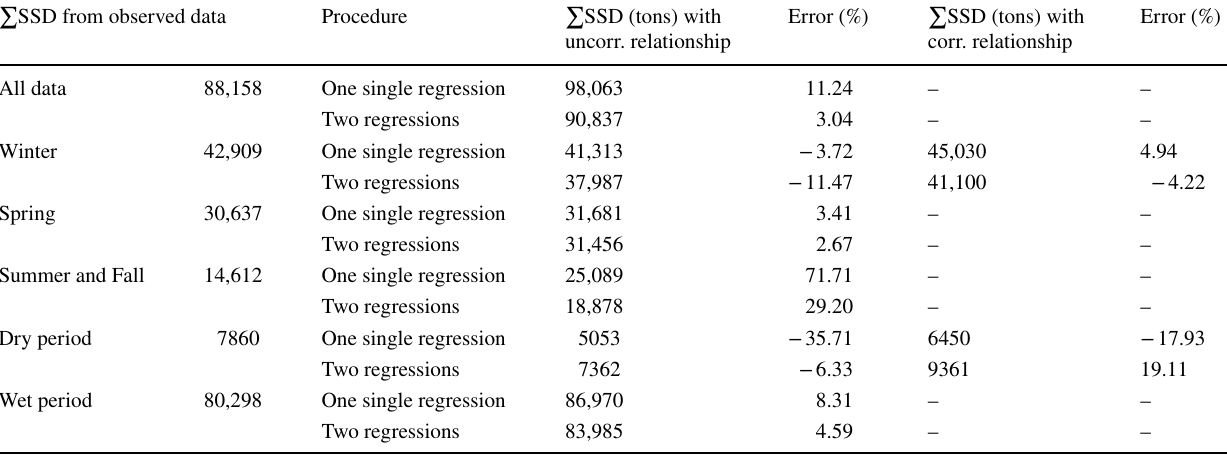
Table 2 Suspended sediment loads in the Ressoul wadi ∑SSD from observed data